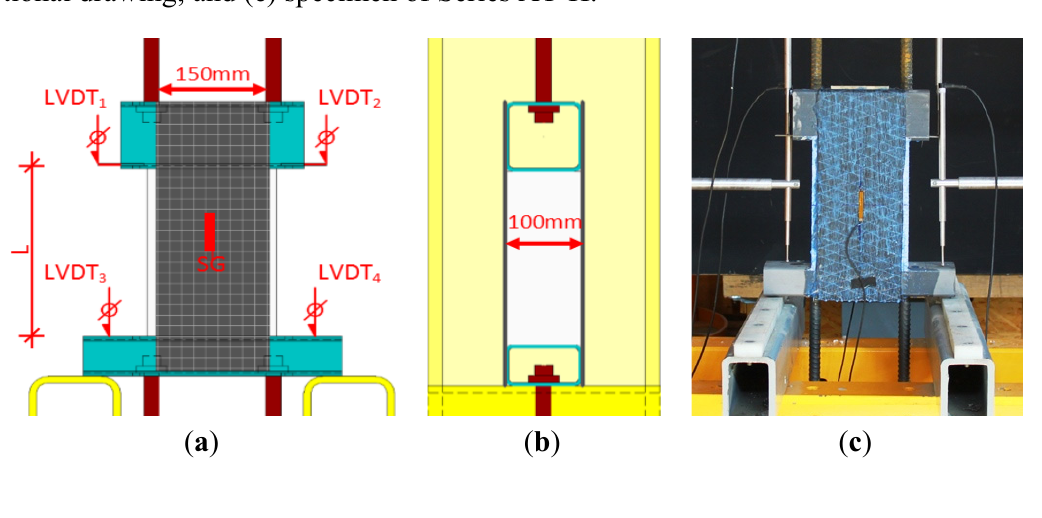
Figure 8. ( a , b ) Model with instrumentation of specimen in Series AT-H in view and sectional drawing; and ( c ) specimen of Series